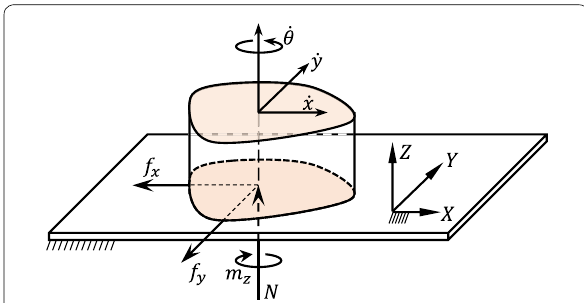
Fig. 2 Contact forces and moment of two objects in planar slippage